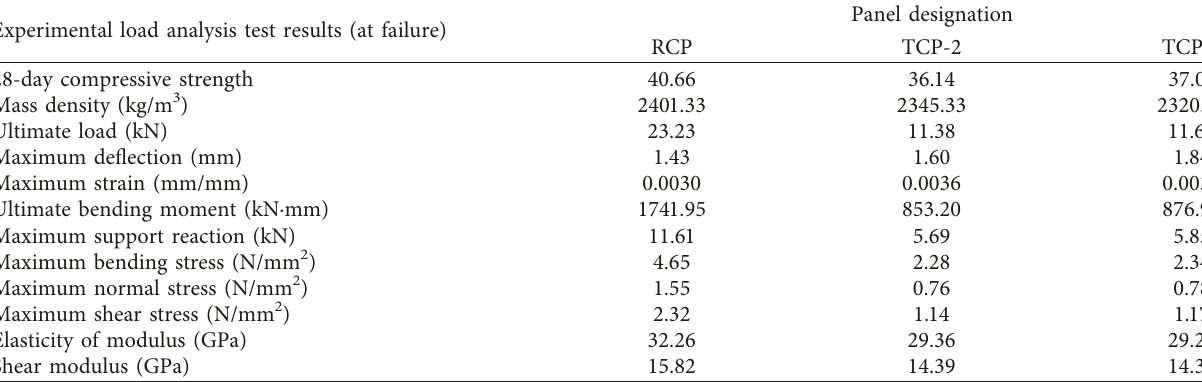
Table 9: Details of experimental load analysis results of the TCPs and